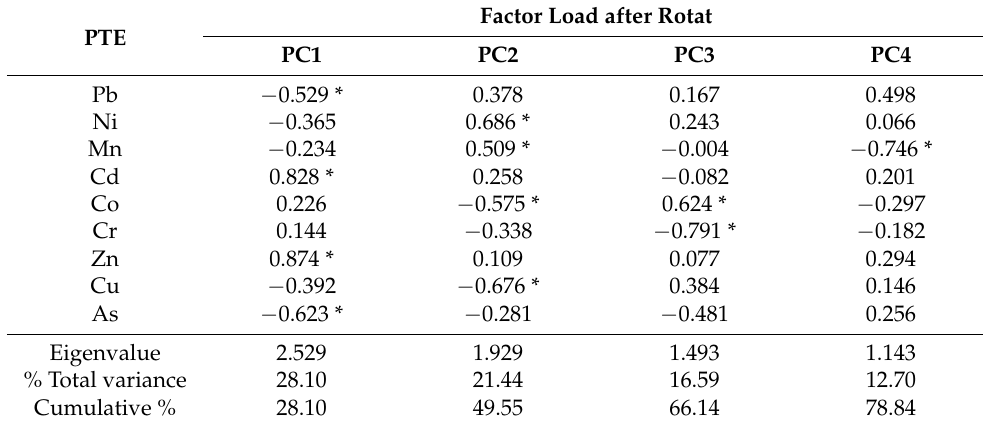
Table 3. The result of principal component Table 3 . The result of principal component analysis.